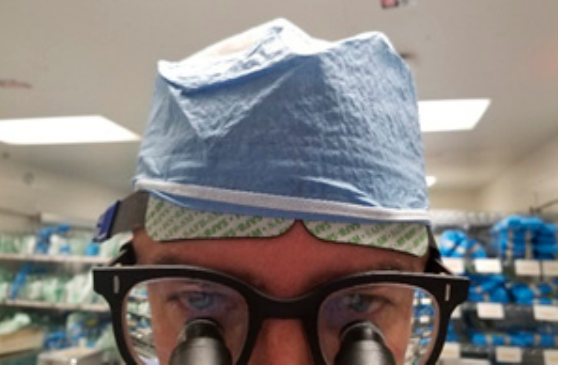
Figure 1. NIRS sensor placement on attending surgeon.